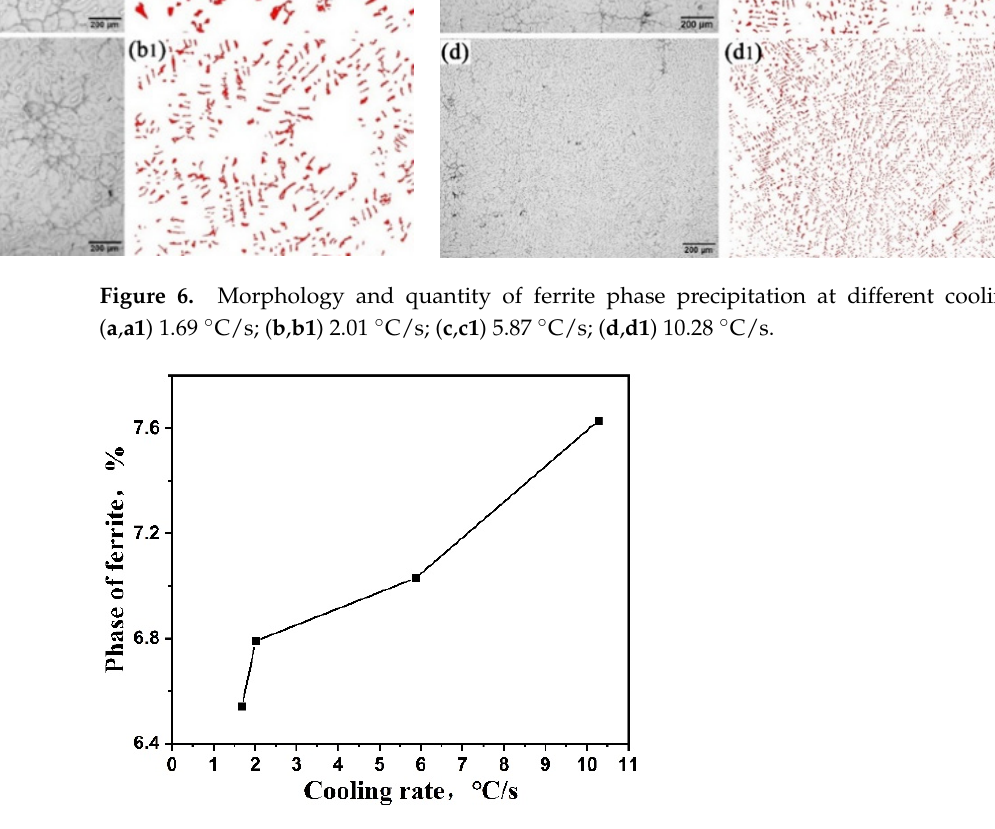
Figure 7. Effect of cooling rate on ferrite phase proportion.